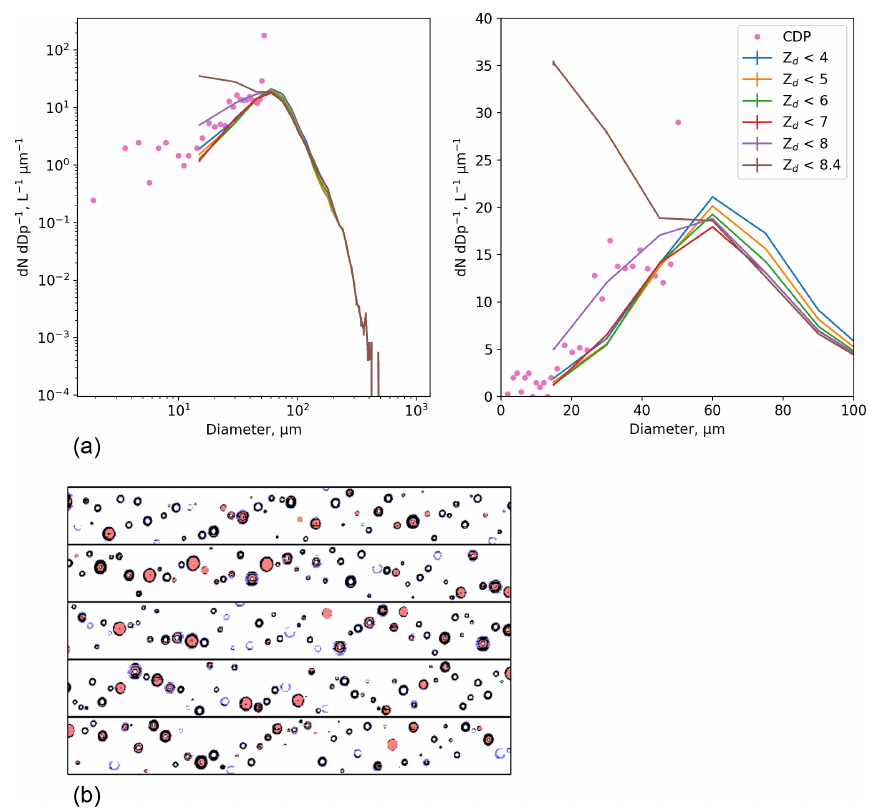
Figure 10. (a) Size distributions in liquid cloud from the CIP-15 and CDP that have been averaged over a straight and level run at 14 ◦ C (16:42:10 to 16:43:15, 5 September 2019). CIP-15 data have been filtered using different Z d thresholds (coloured lines). The right graph shows a subset of the full size distribution shown in the left graph. Panel (b) shows example CIP-15 images from this period. Decreases in detector intensity of 25% to 50%, 50% to 75% and >75% are shown as light blue, black and orange pixels,